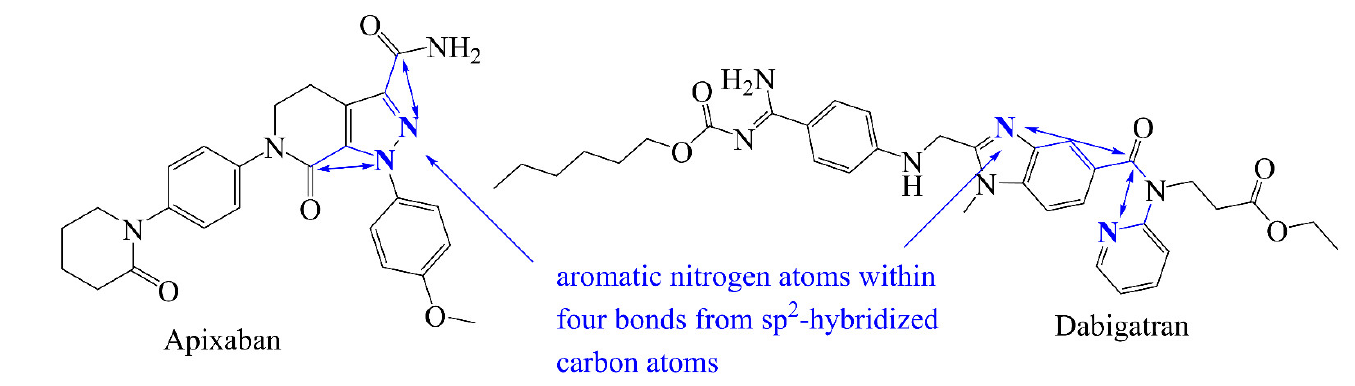
Figure 4. Marketed factor Xa inhibitors with aroN_sp2C_4B (blue colored).